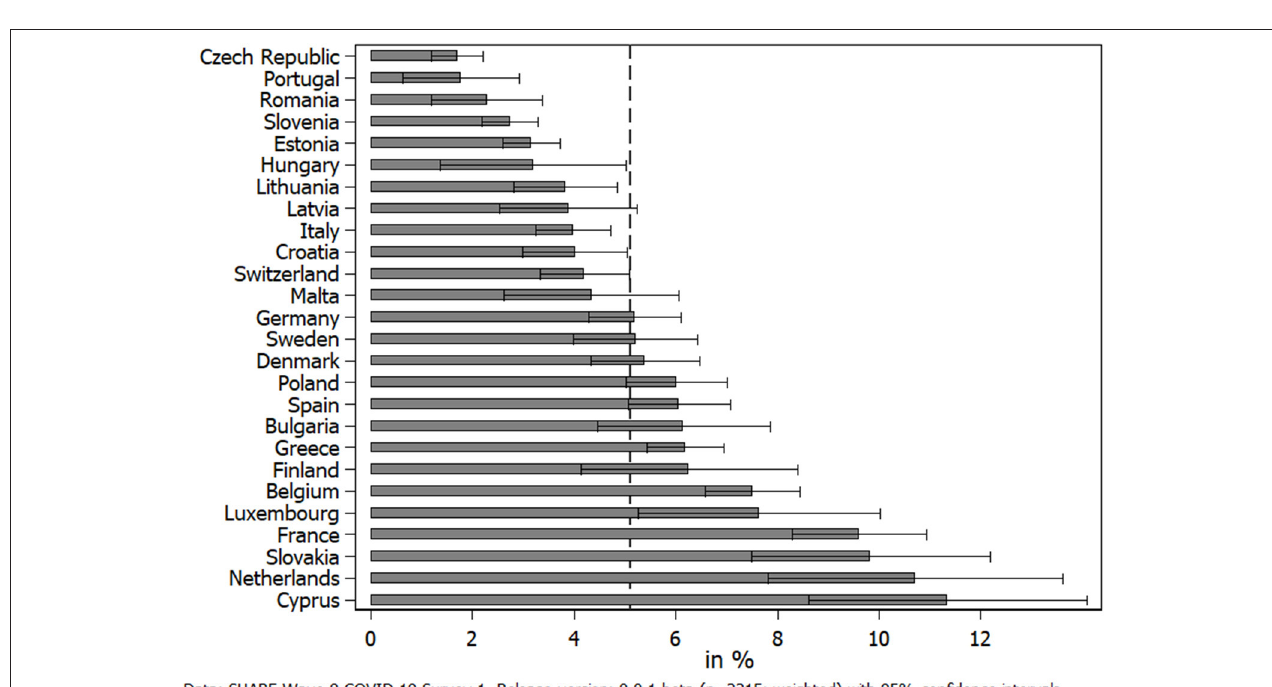
FIGURE 4 | Percent of respondents receiving home care by others from outside their own household since the outbreak of the pandemic.